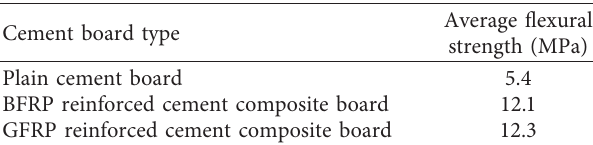
Table 2: The flexural strength of cement board. Cement board type